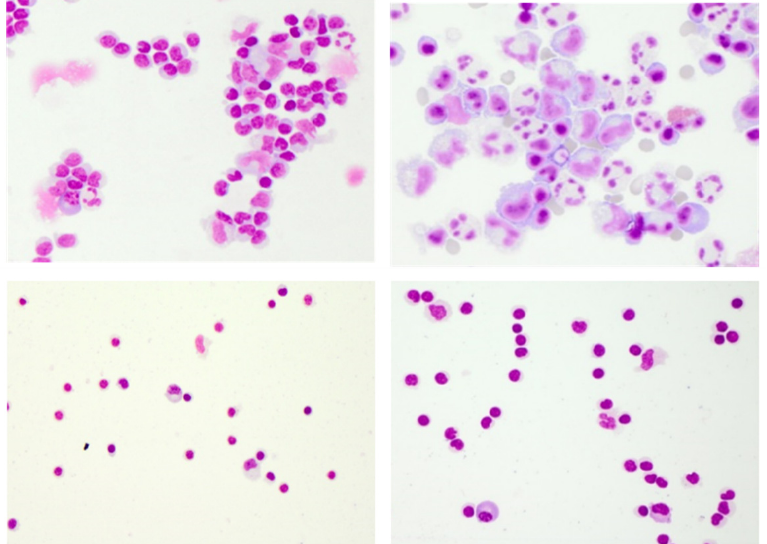
Figure 4. Limitations of conventional CSF cytology. May–Grünwald staining illustrating a case of Lyme neuroborreliosis with antibiotic pre-treatment resembling viral meningitis ( upper left ), an atypical case of Varicella Zoster Virus-meningitis with large hyperreactive cells and plasma cells resembling aseptic bacterial meningitis or Epstein-Barr Virus infection, possibly in malignant trans- formation ( upper right ), and the almost identical cytomorphological findings of the two autoim- mune CNS diseases multiple sclerosis ( lower left ) and anti-N-methyl-D-aspartate receptor enceph- alitis ( lower right ). Cytology specimen kindly provided by the Department of Laboratory Medicine, Uniklinikum Salzburg, Paracelsus Medical University Salzburg (Chair: Univ-Prof Dr. Elisabeth Haschke-Becher).